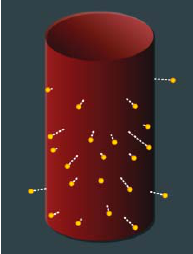
Figure 3. Defining shape of object based on set of object